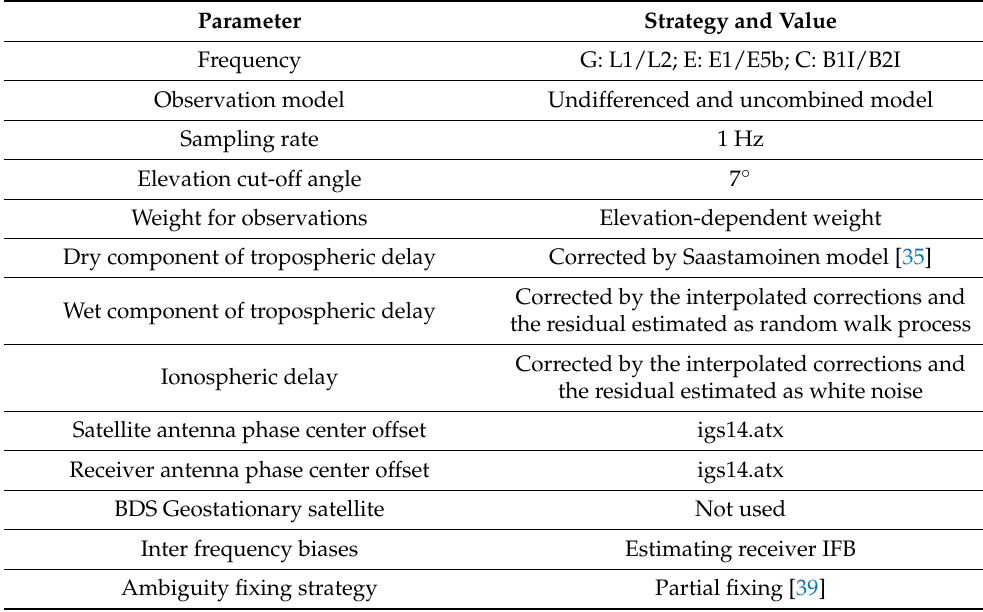
Figure 5. The distribution of reference stations used in Wuhan and Zhengzhou experiments to generate atmospheric corrections. ( a ) Reference station with an average inter-station distance of approximately 50 km in Wuhan. ( b ) Reference station with an average inter-station distance of approximately 25 km in Zhengzhou. Table 2. Processing strategy at user side of